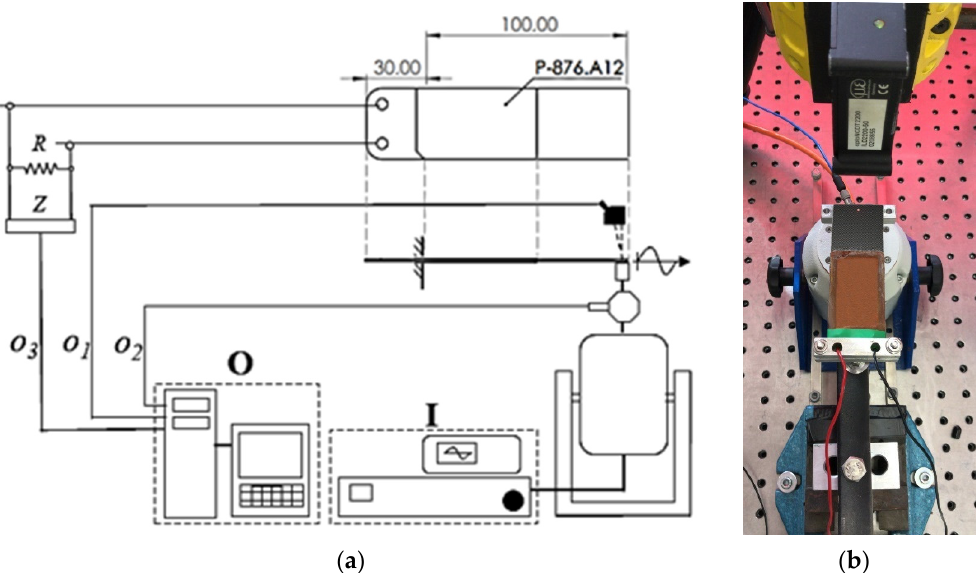
Figure 11. ( a ) Setup scheme (signal generator and amplifier ( I ), data acquisition system ( O ), linear displacement signal ( o 1 ), load cell signal ( o 2 ), PPT signal ( o 3 ), probe ( Z ), resistor ( R )), and ( b ) experimental setup.